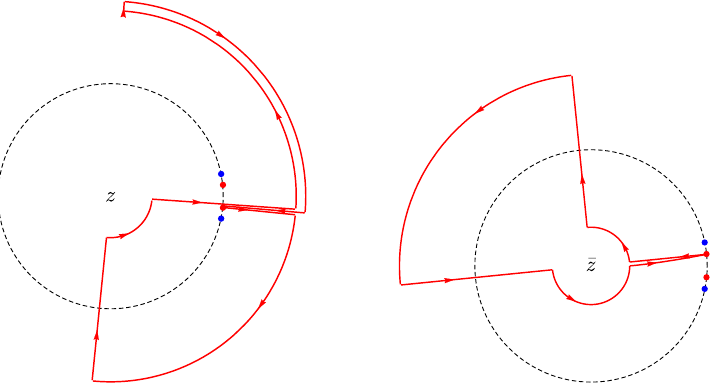
Figure 9 . We map the boundary coordinates to the plane and follow the trajectory of the red operator (red contour) as we send it along the orange path in (cid:12)gure 5. The large arcs represent in(cid:12)nity, the small circle arcs represent zero, while the dashed circle is the unit circle. Left is the z and right is the (cid:22) z coordinate. The former encircles a blue operator, the latter does not.